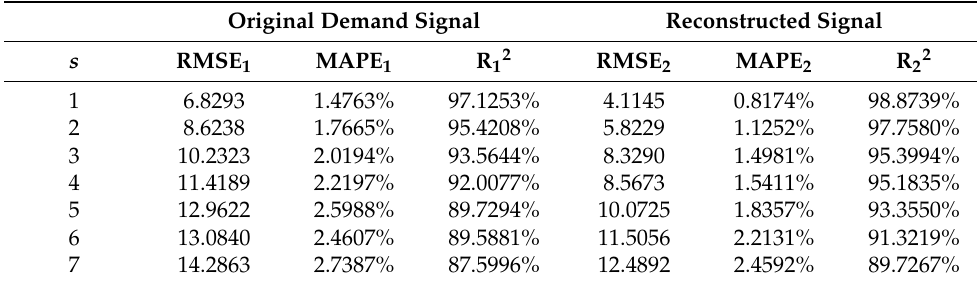
Table 1. Comparison of error index between original demand signal and reconstructed